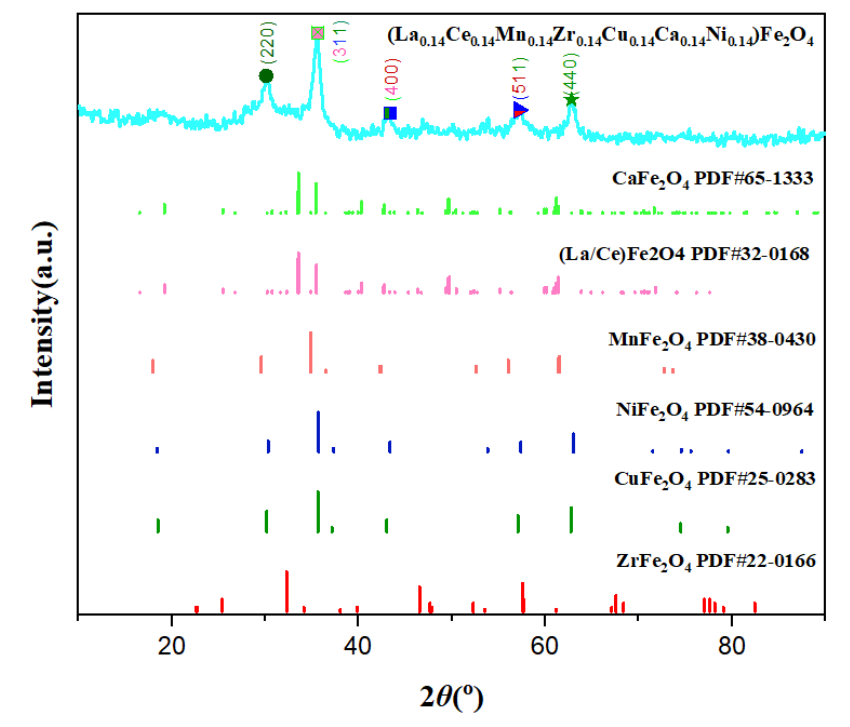
Figure 3. XRD curve of ( La 0.14 Ce 0.14 Mn 0.14 Zr 0.14 Cu 0.14 Ca 0.14 Ni 0.14 ) Fe 2 O 4